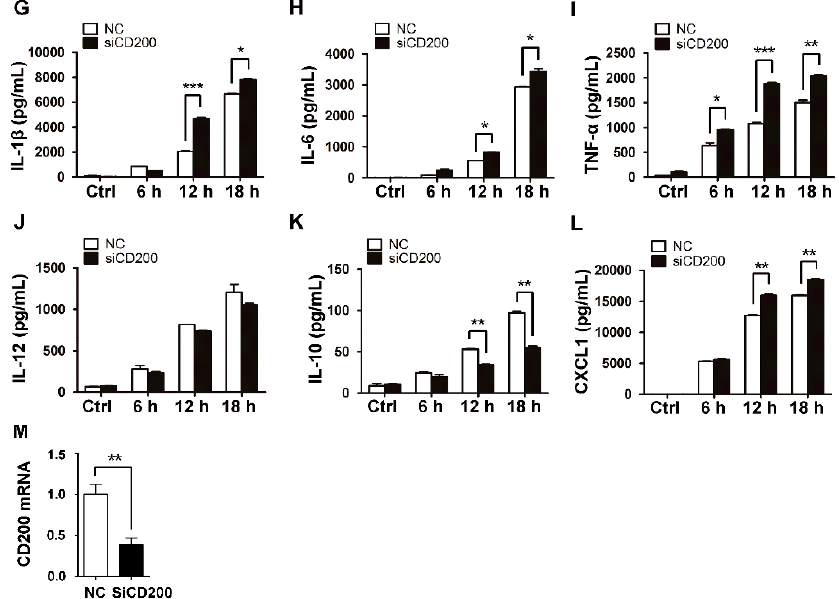
Figure 3. Knockdown of CD200 enhances S. aureus -induced inflammatory responses. Mouse PEMs were transfected with siCD200 or NC siRNA for 48 h, and then stimulated with S. aureus (MOI = 1) for indicated time periods (0–18 h). ( A – F ) Relative mRNA levels of IL-1 β ( A ), IL-6 ( B ), TNF- α ( C ), IL-12p40 ( D ), IL-10 ( E ), or CXCL1 ( F ) were detected by qPCR, with β -actin as an internal control. ( G – L ) The amount of IL-1 β ( G ), IL-6 ( H ), TNF- α ( I ), IL-12 ( J ), IL-10 ( K ), or CXCL1 ( L ) in the cell culture supernatant was determined by ELISA. ( M ) The CD200 knockdown efficiency was detected by qPCR. Results are expressed as the mean ± SD of three independent experiments; * p < 0.05, ** p < 0.01, *** p < 0.005.